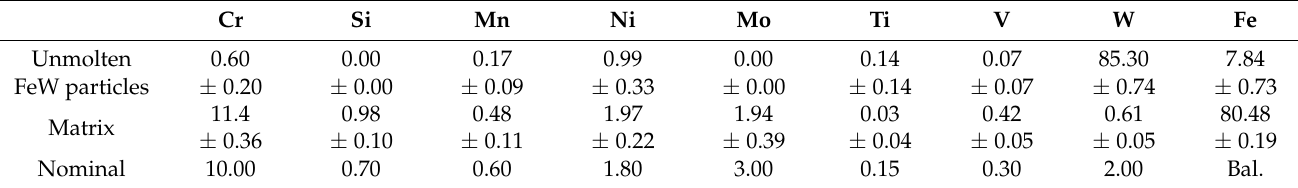
Table 7. EDS point analysis to measure the local chemical composition in the H-MIX sample in an unmolten FeW particle and in the “homogeneous” metal